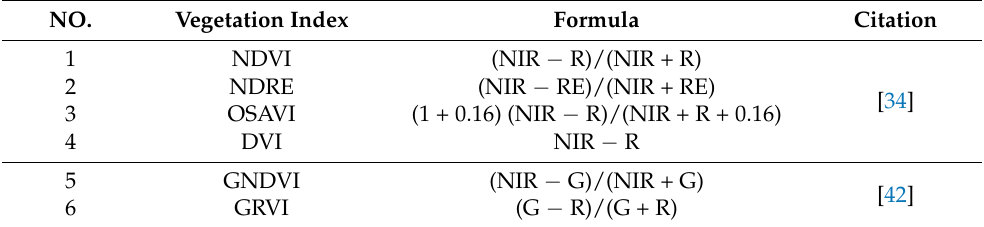
Table 1. Formulas and corresponding citation for vegetation